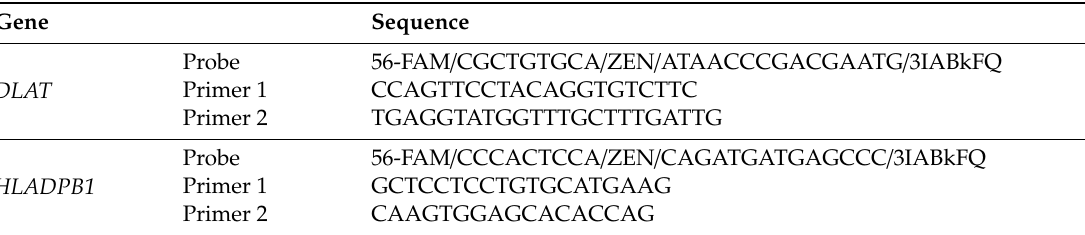
Table 4. qPCR primer-probe set